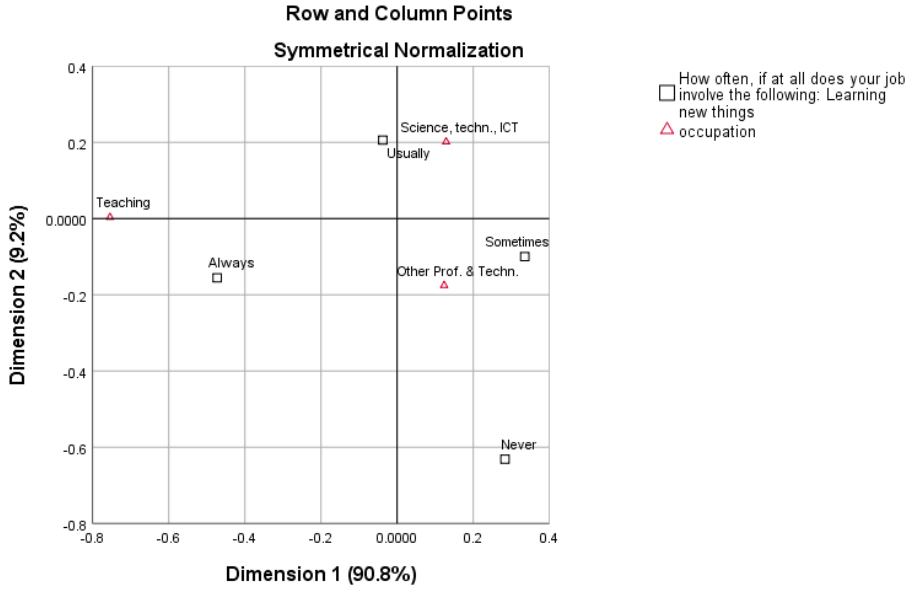
Figure 2. Correspondence analysis between occupation categories and frequency of learning new things at work. Source: authors calculation on data from ESJ (Wave 1) [70]